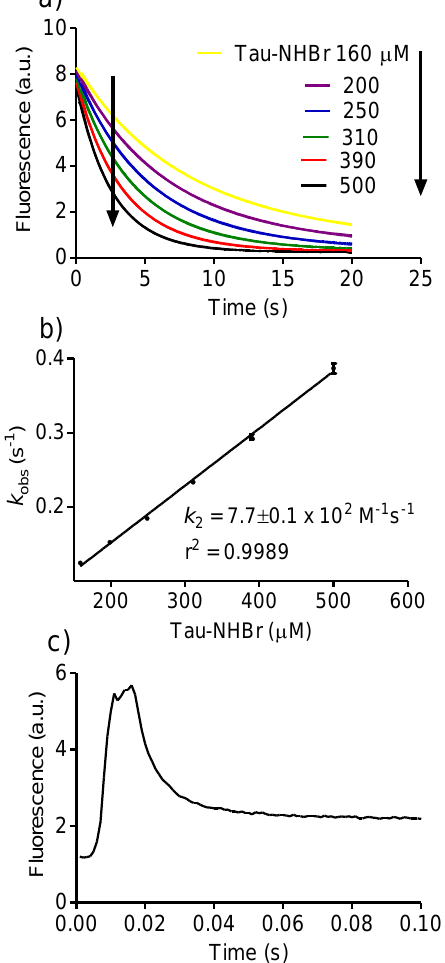
Figure 1. Reactivity of Tau-NHBr and HOBr with tryptophan. ( a ) Kinetic profile of tryptophan consumption for determination of k obs under pseudo-first-order experimental conditions. The reaction mixture was composed of 25 µM tryptophan and increasing concentrations of Tau-NHBr in 50 mM phosphate buffer, pH 7.0 at 25 °C. The stopped-flow system was set as follows: excitation, 280 nm LED; and emission, 325 nm cut-off filter; ( b ) Determination of the bimolecular rate constant ( k 2 ) for the reaction between tryptophan and Tau-NHBr; ( c ) Kinetic profile of tryptophan (25 µM) consumption by HOBr (50 µM). The results are the mean of three experiments.